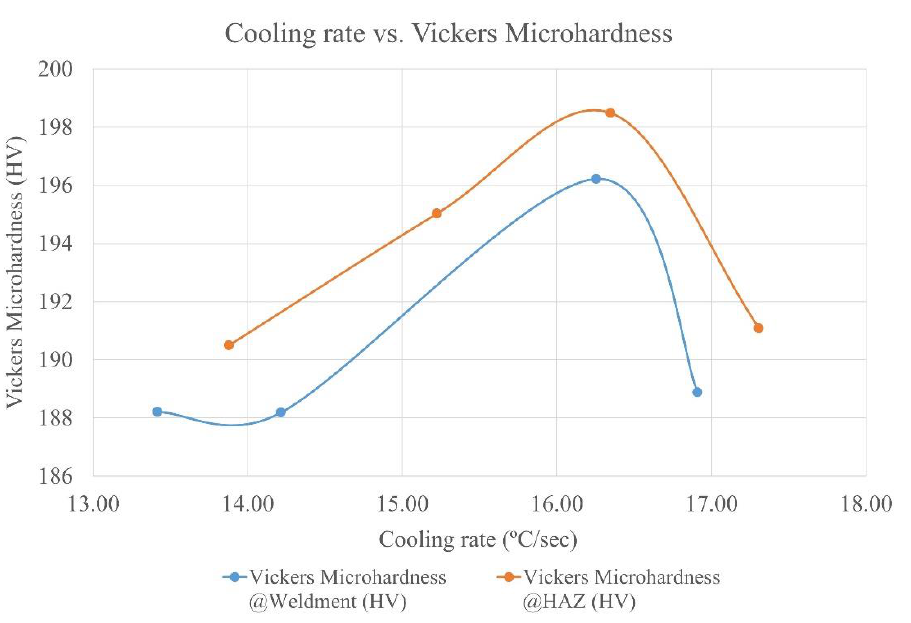
Figure 16. Vickers microhardness results according to the experimental design.